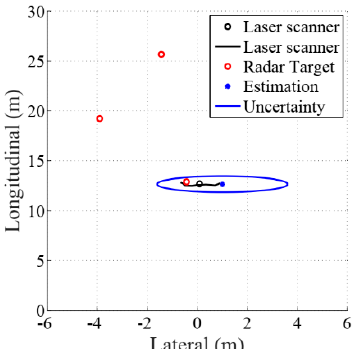
Figure 4. Radar measurements (red) need to be associated with the current relative position estimate (blue). The Mahalanobis distance takes also the current estimation uncertainty (blue ellipse) into account.